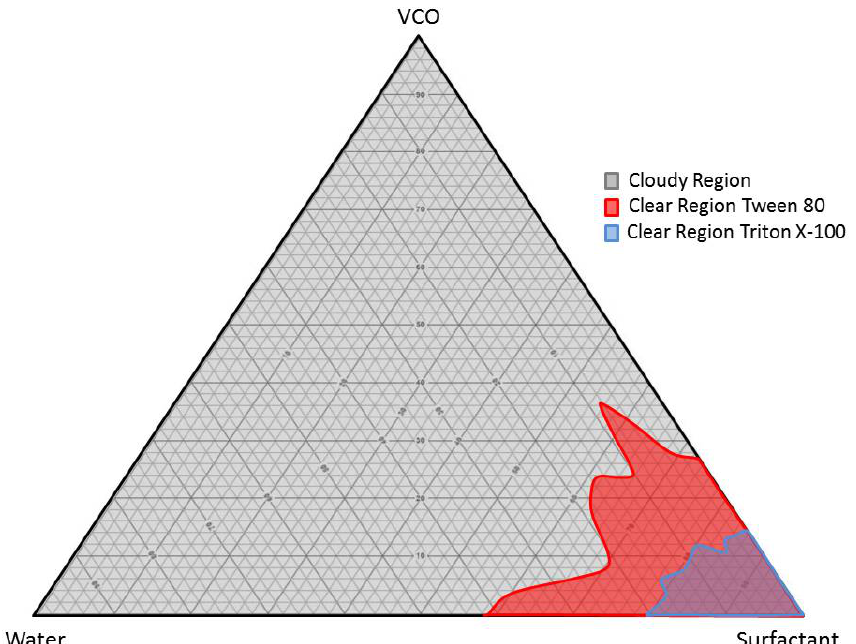
Figure 1. The ternary phase diagram of VCO microemulsion by using Tween 80 and TritonX-100 surfactants.